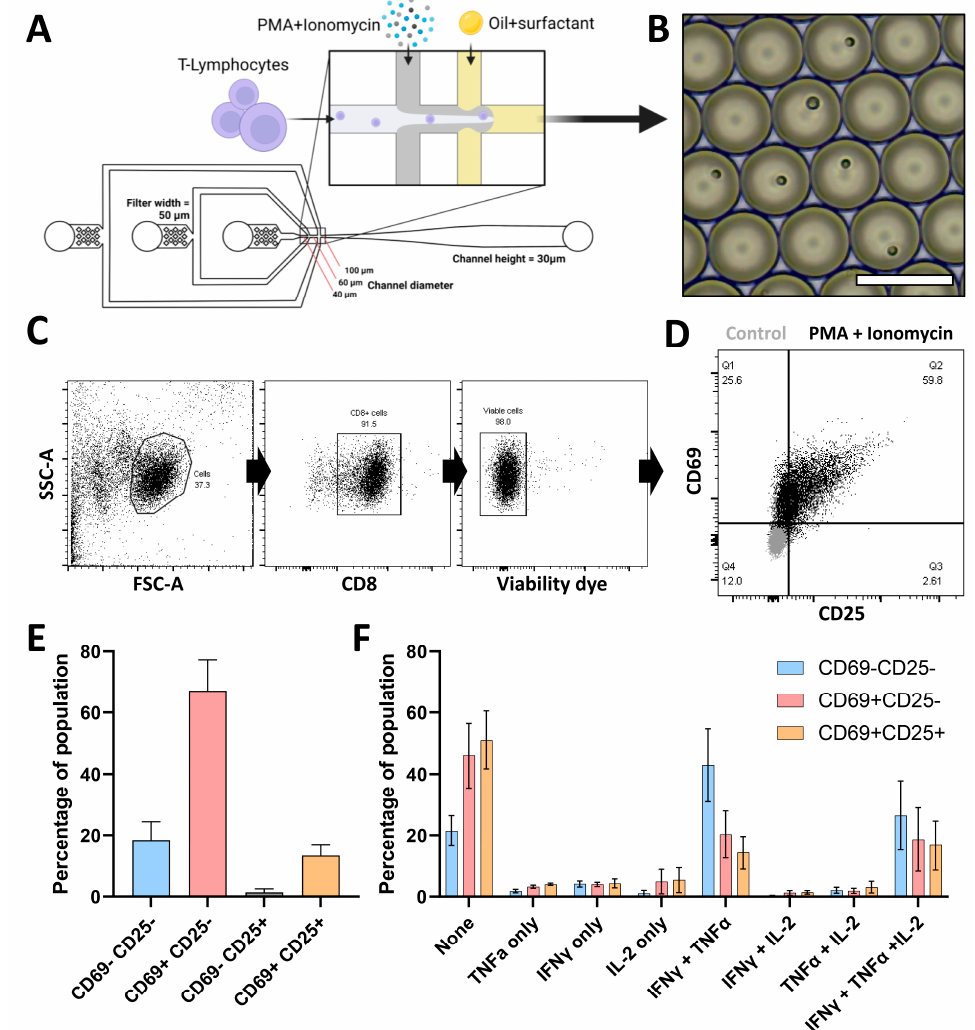
Figure 1. Single-cell CTL activation using soluble stimuli. ( A ) Layout of the microfluidic device used for droplet production including popped-out schematic of droplet formation, scale bar represents 500 µm. Layout is a direct copy of the photolithography mask design, and channel height is equal throughout. ( B ) Brightfield microscopy image of aqueous droplets containing single CTLs. Scale bar = 100 µm. ( C ) Gating strategy for flow cytometry data to select viable CD8-positive cells. ( D ) Marker expression of selected viable CD8-positive cells for CD69 and CD25 activation markers, either after stimulation with PMA + Ionomycin (black dots) or unstimulated (grey dots). Data display one representative donor. ( E ) Prevalence of populations of PMA + Ionomycin activated CTLs based on CD25 and CD69 expression. Data represent SEM of n = 4 biological replicates. ( F ) Bar graph displaying the frequency of different profiles of secretion as exhibited by the three prevalent populations of PMA + Ionomycin stimulated CTLs. Data represent average values of n = 3 biological replicates.